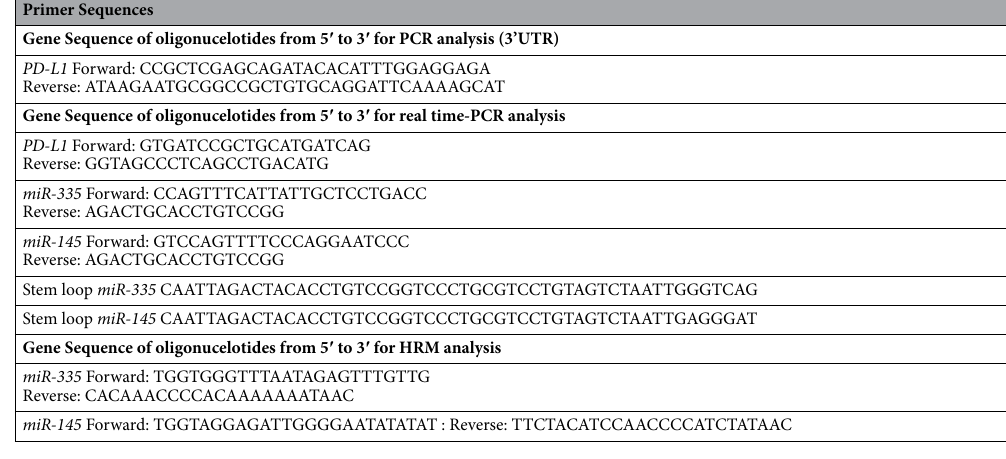
Table 2. Relative primers used for PCR, real-time PCR, stem-loop sequences and